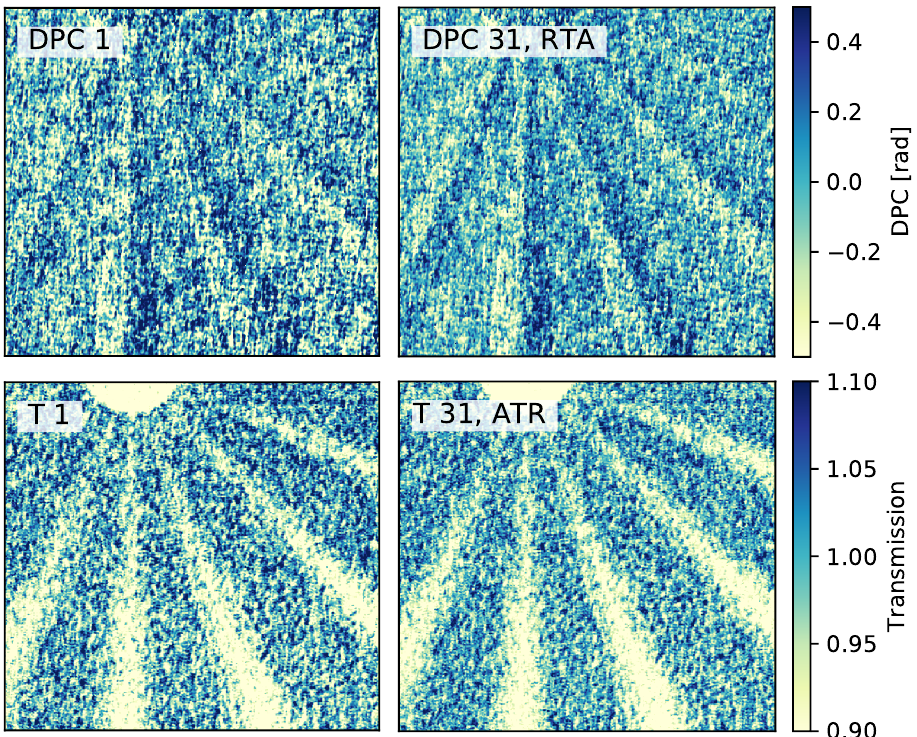
Figure 7. Two retrieved DPC images (DPC1 and DPC31,RTA) and transmission images (T1 and T31,ATR) for a visual comparison of the improved image quality. For the DPC image comparison, an image retrieved using reference image 5 is shown on the left (DPC1) and on the right an image retrieved using all reference images and the RTA method (DPC31,RTA). It can be seen with the naked eye that the noise is reduced and hence, the double wedges are easier to recognize. For the comparison of the transmission image, the image retrieved with reference image 5 (T1) is again compared with the image retrieved using the ATR method and reference image combination 31 (T31,ATR). Here, hardly any improvements are visible. The lower STD of the right image can vaguely be seen in the free